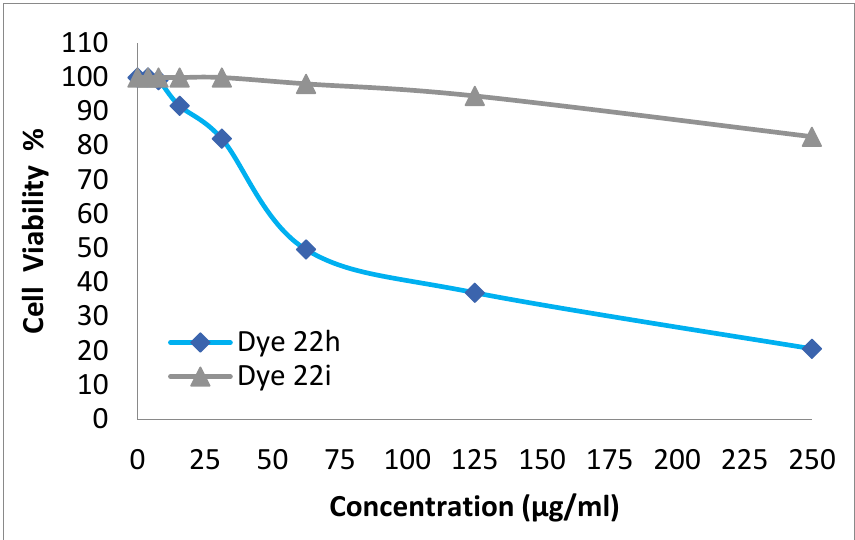
Figure 7. Antitumor (MCF-7) activities of disperse dyes 22h and 22i.